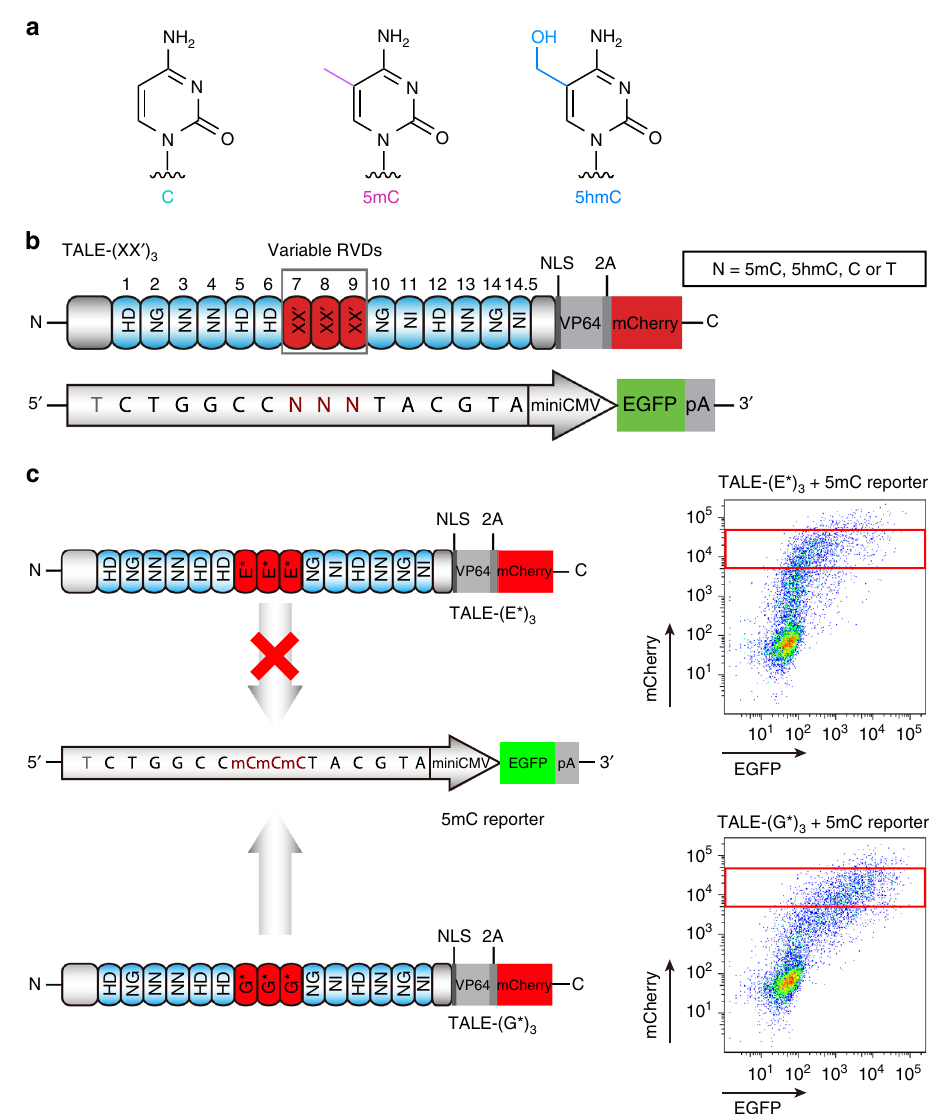
Fig. 1 The screening platform to completely evaluate all potential TALE RVDs in recognizing modi fi ed cytosines. a Chemical structures of C, 5mC, and 5hmC. b The screening system for novel RVDs against modi fi ed cytosine is composed of a TALE activator and a GFP expression reporter. The TALEs contain 14.5 repeats fused with VP64. The 7 th to 9 th RVDs are substituted by the testing RVD XX ′ , which makes an archive of 420 TALEs. The X and X ′ represent for the 12 th and 13 th residues, respectively. The 5mC and 5hmC reporters are linear DNA fragments ampli fi ed utilizing a forward primer with 5mC or 5hmC embedded on position 7 th to 9 th and a normal reverse primer. The C and T reporters are circular DNA described as previous 13 . c When the customized TALE does not bind to the reporter, for instance, between TALE-(E*) 3 and the 5mC reporter, the GFP expression is at a basal level. In contrast, when the TALE binds tightly to the reporter, as shown for TALE-(G*) 3 to the 5mC reporter, the GFP expression is up-regulated. mCherry intensity implies the quantity of transfected TALE-(XX ′ ) 3